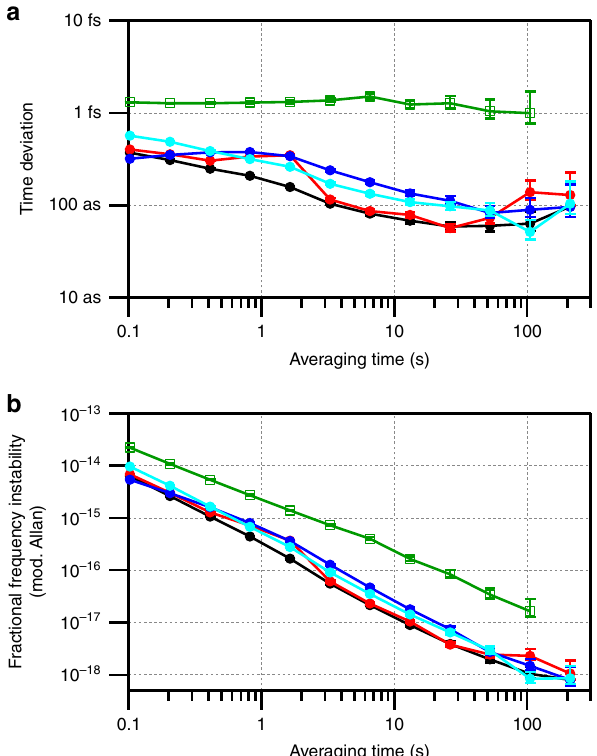
Fig. 4 Time deviations and modi fi ed Allan deviations. a Time deviation for periods of active synchronization off the quadcopter with 0 – 20 m s − 1 motion (open green squares) and with the in-line swept delay line with ± 24 m s − 1 motion and a free-space pathlength of 0 m (red circles), 2 km (blue circles), and 4 km (cyan circles). Uncertainty bars are the statistical uncertainty on the calculated deviations. Also shown is the time deviation at 0 m s − 1 and 0 m free-space path (black circles). The elevated time deviation for the quadcopter data is due to the many signal fades and calibration uncertainties associated with the tracking terminal. The O- TWTFT synchronization bandwidth was 10 Hz. b Corresponding modi fi ed Allan